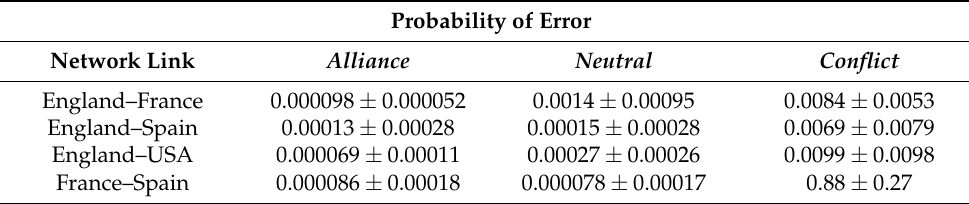
network using deep learning machines with five hidden layers and a total of 756 units hierarchically arranged and trained 1000 Epochs with the scaled conjugate gradients algorithm [45,52]. The results were validated using a statistical ten-fold cross-validation procedure [53] using the datasets built from the discrete time series corresponding to the evolution of network links (i.e., the evolution of political relationships between pairs of countries). Clearly, the model can predict the next state of the network with a probability of error close to